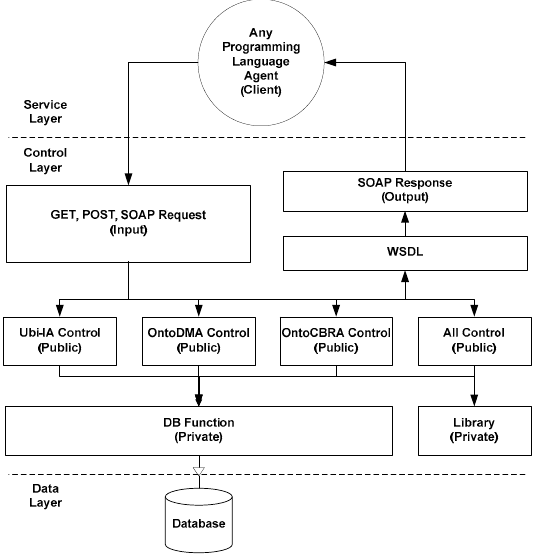
Figure 2. Flow chart of WIAS operation.